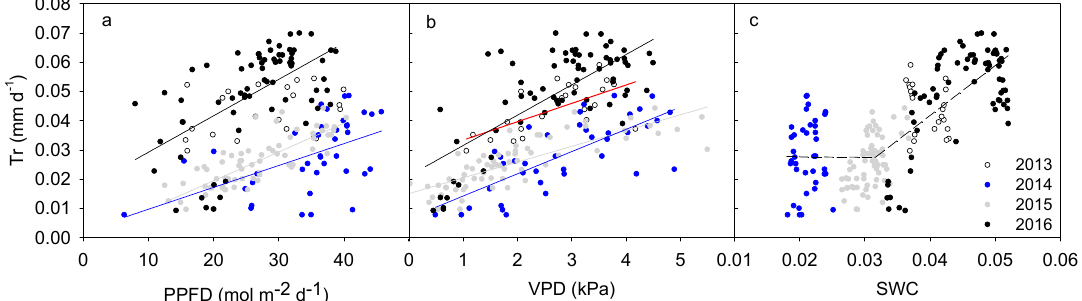
Figure 3. Responses of daily canopy transpiration (T r ) to daily accumulative photosynthetic photon flux density (PPFD, a ), mean vapor pressure deficit (VPD, b ) and mean volumetric soil water content (SWC, c ) during the half of the growing season (1 August to early October) from 2013 to 2016. Lines in the first two figures were fitted with linear functions in each of the monitored four years. Line colors represent different years while the discontinuous line in the last figure was fitted with a linear function based on all data in the four years.